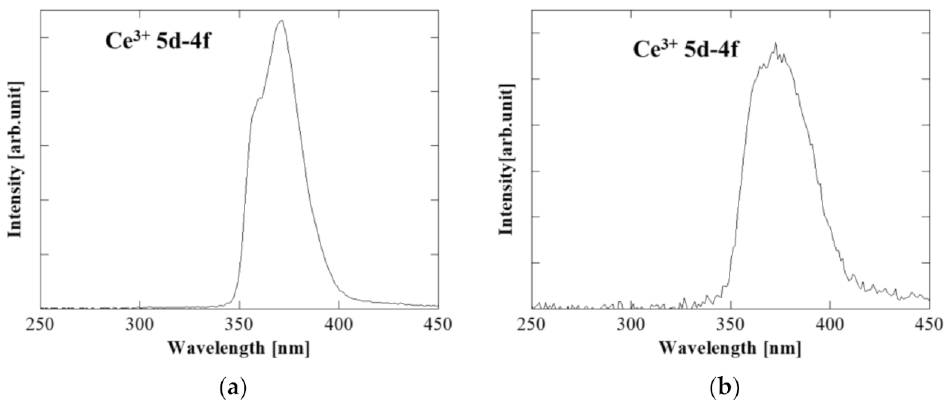
Figure 5. RL spectra under X-ray irradiation of prepared ( a ) K 2 CeCl 5 /LiCl and ( b ) CeCl 3 /SrCl 2